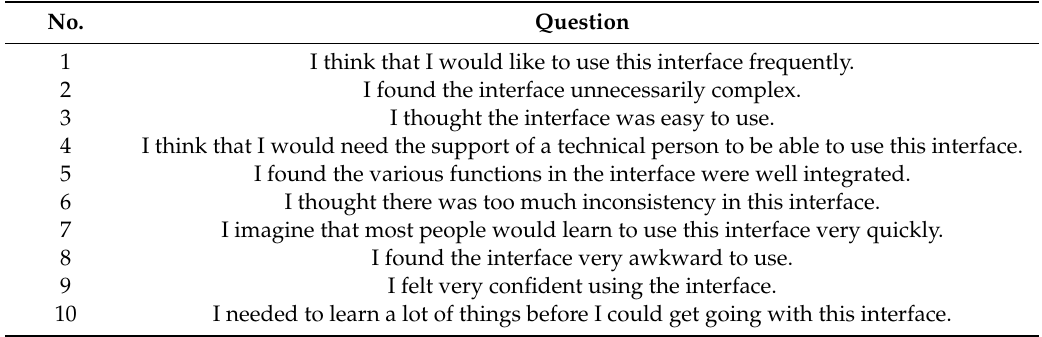
Table 2. Likert Scale items of system usability scale (SUS)